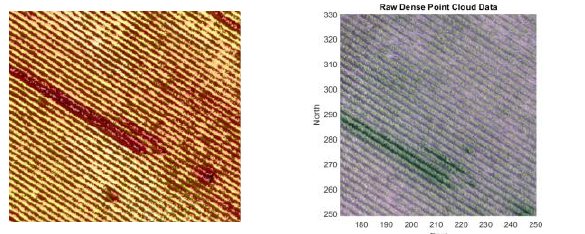
Figure 9: Result of vine identification algorithm using VIS and LWIR data (left) and (right) expanded view of